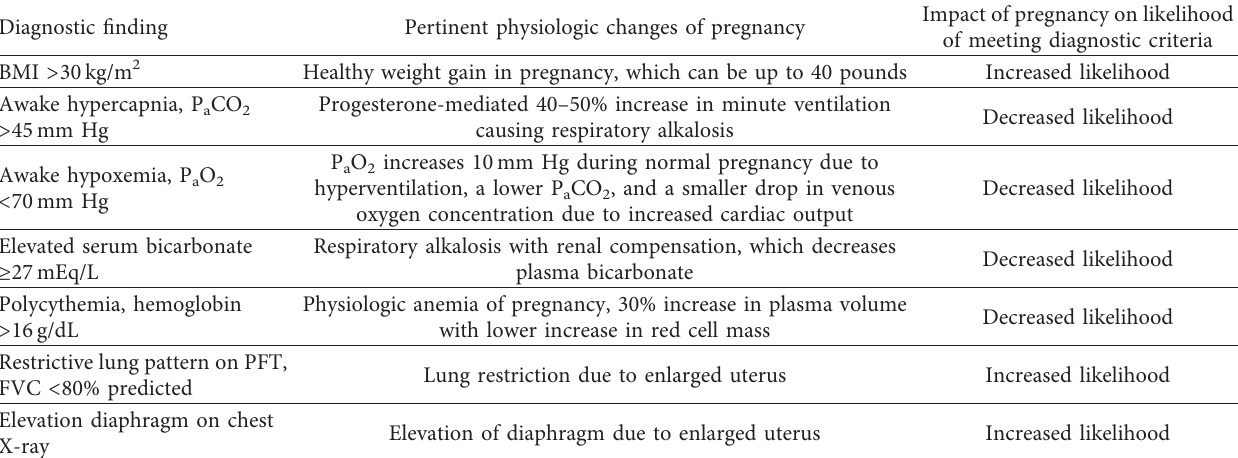
Table 2: Impact of physiologic changes of pregnancy on diagnostic findings associated with obesity hypoventilation